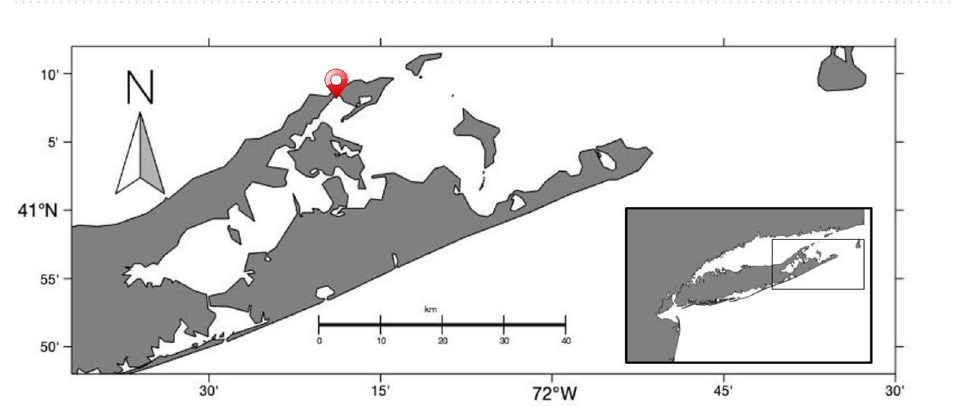
Figure 2. Peconic Bay in Long Island, New York. The location icon indicates the Orient Harbor sampling